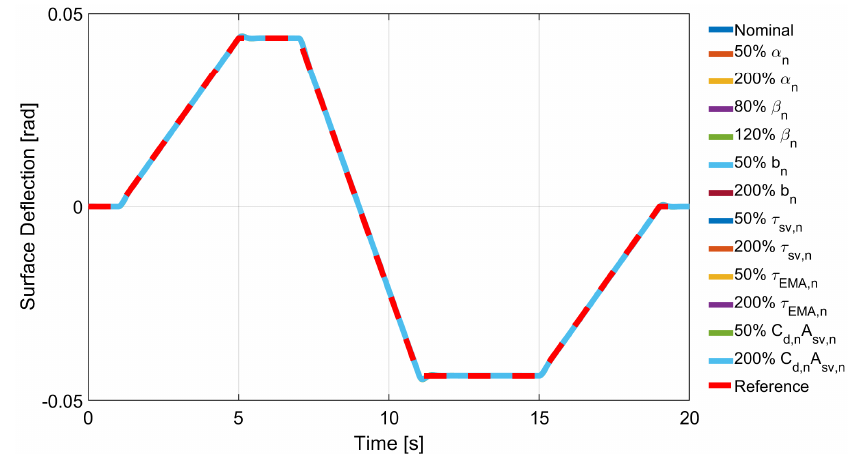
Figure 21. Simulation #3: Surface Deflection compared to the reference signal.